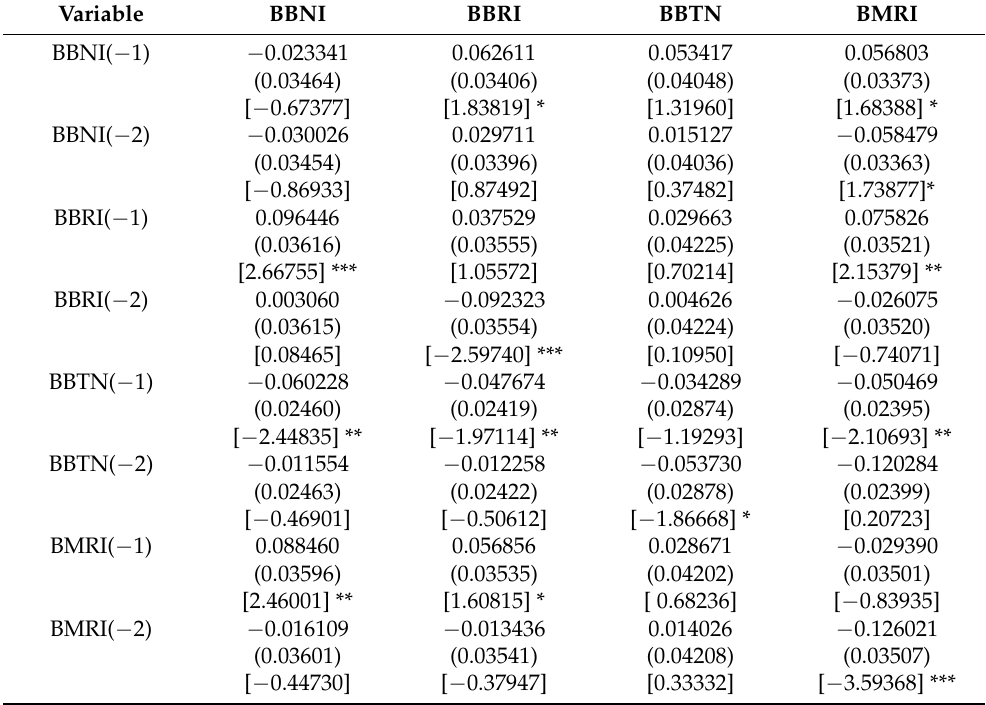
Table 5. Vector autoregression